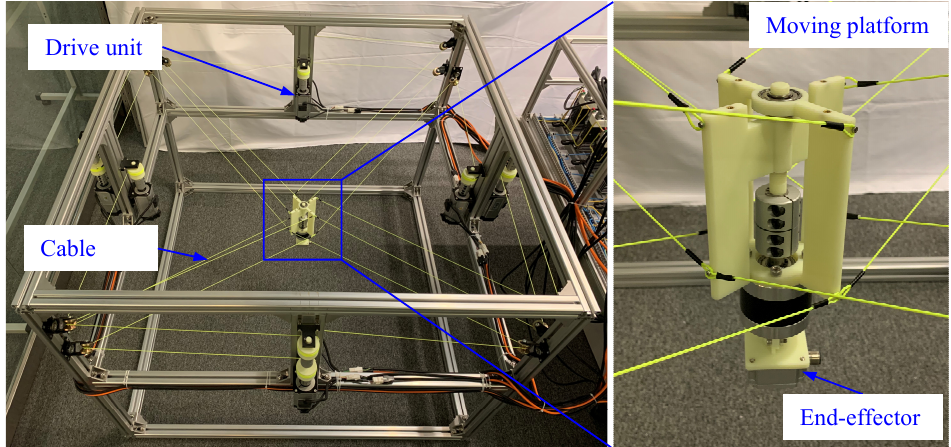
Figure 1. Prototype of the novel cable-driven parallel robot